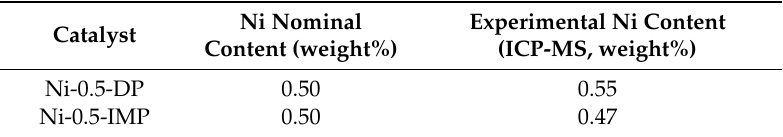
Table 1. Metallic content of the solids as determined by inductively-coupled plasma mass spectrometry (ICP-MS). DP: deposition–precipitation; IMP: impregnation.